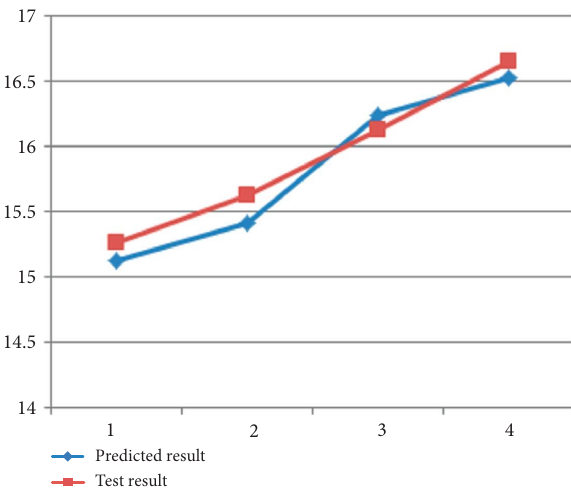
Figure 27: Iterative diagram of the ant colony algorithm.